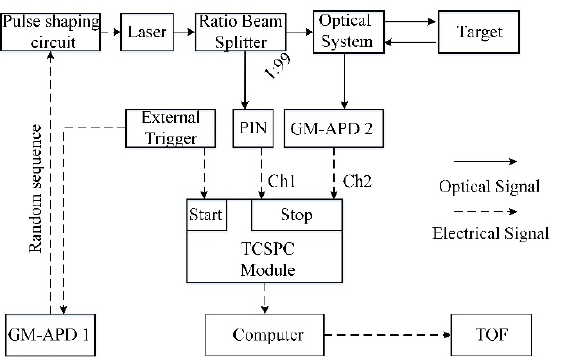
Figure 1. Structure diagram of true random coding photon counting lidar based on Gm-APD.